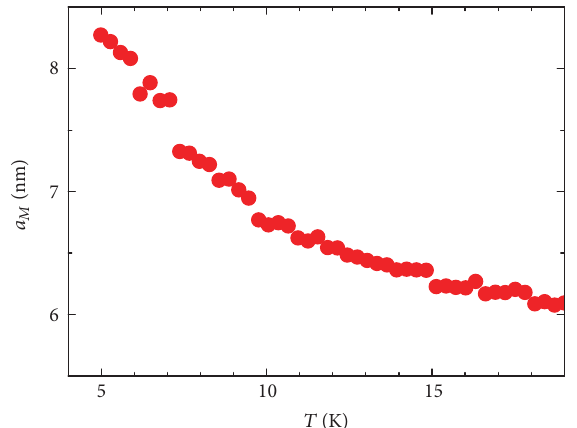
Figure 4: Temperature dependence of the localization length 𝑎 𝑀 . Data are for 𝐻 = 80 kOe.